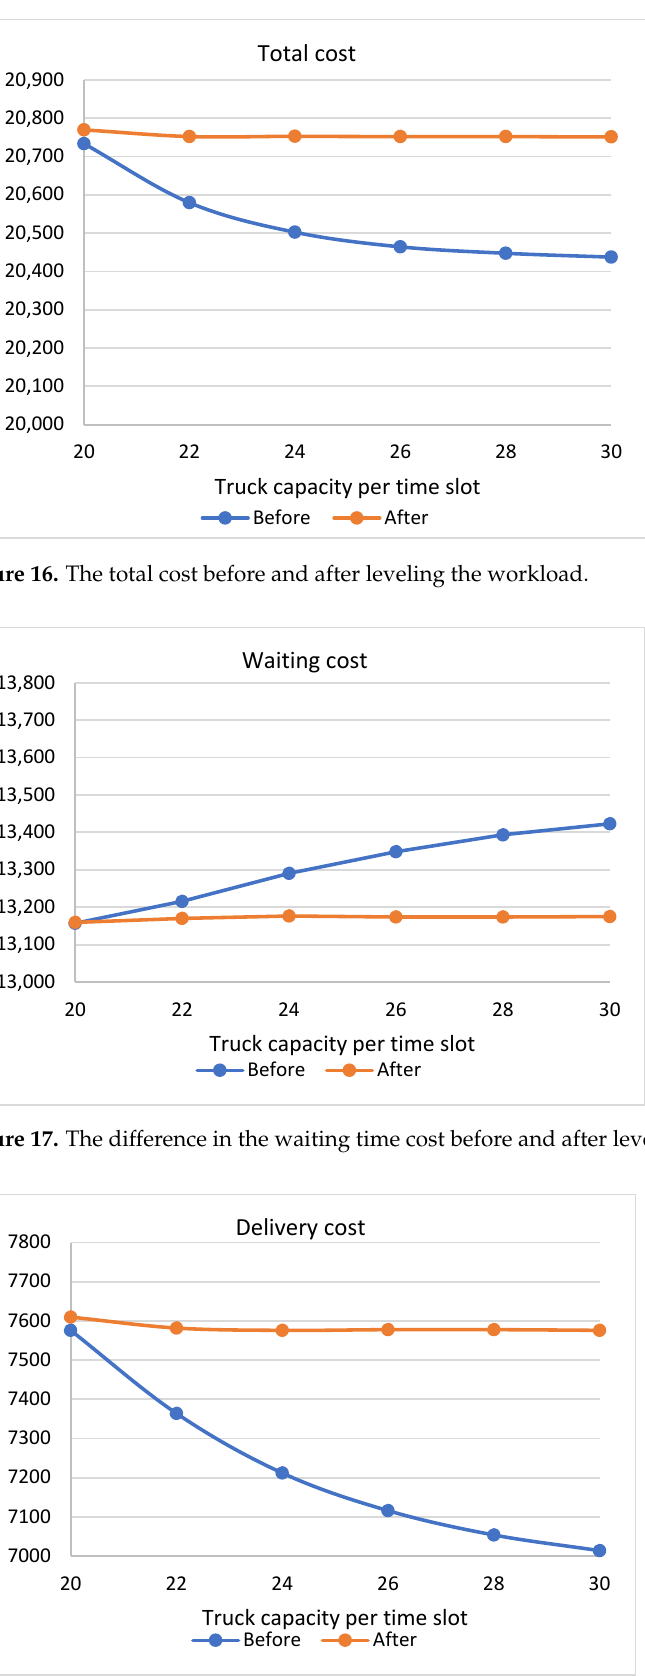
Figure 18. The change in the delivery cost before and after leveling the workload.